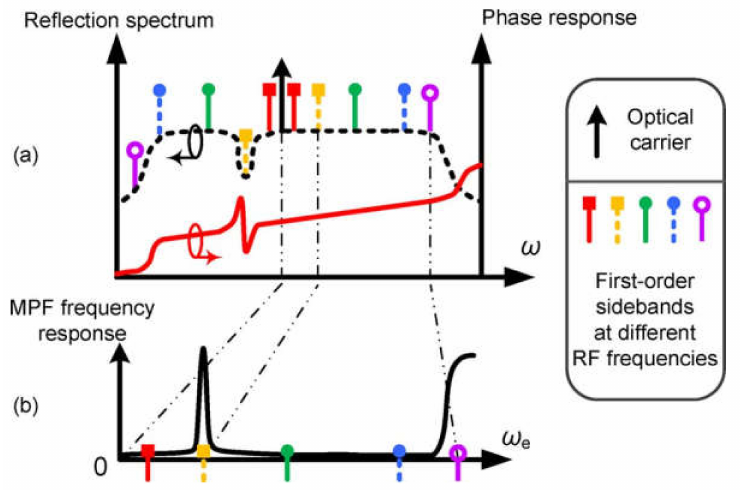
Figure 11. Illustration of the operation of a microwave photonics filter based on PS-FBG: ( a ) Reflection spectrum (dashed line) and phase response (solid line) of the PS-FBG; ( b ) frequency response of the MPF (Adapted with permission from Ref [56]. Copyright 2012,